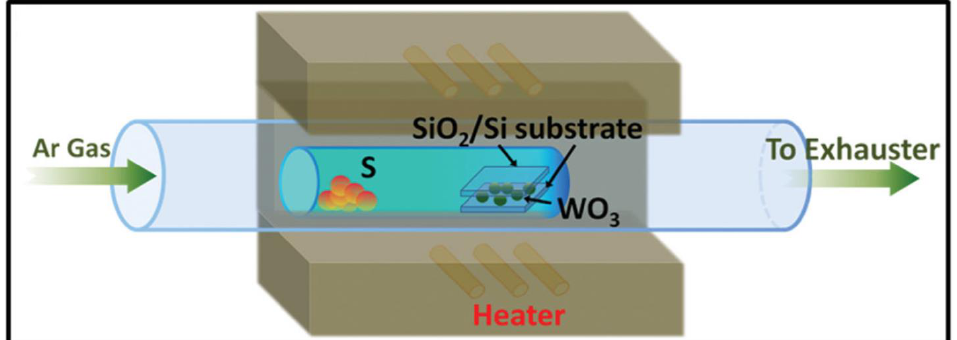
Figure 11. Schematic illustration of the chemical vapor deposition system used for the synthesis of WS 2 . Reproduced with permission from